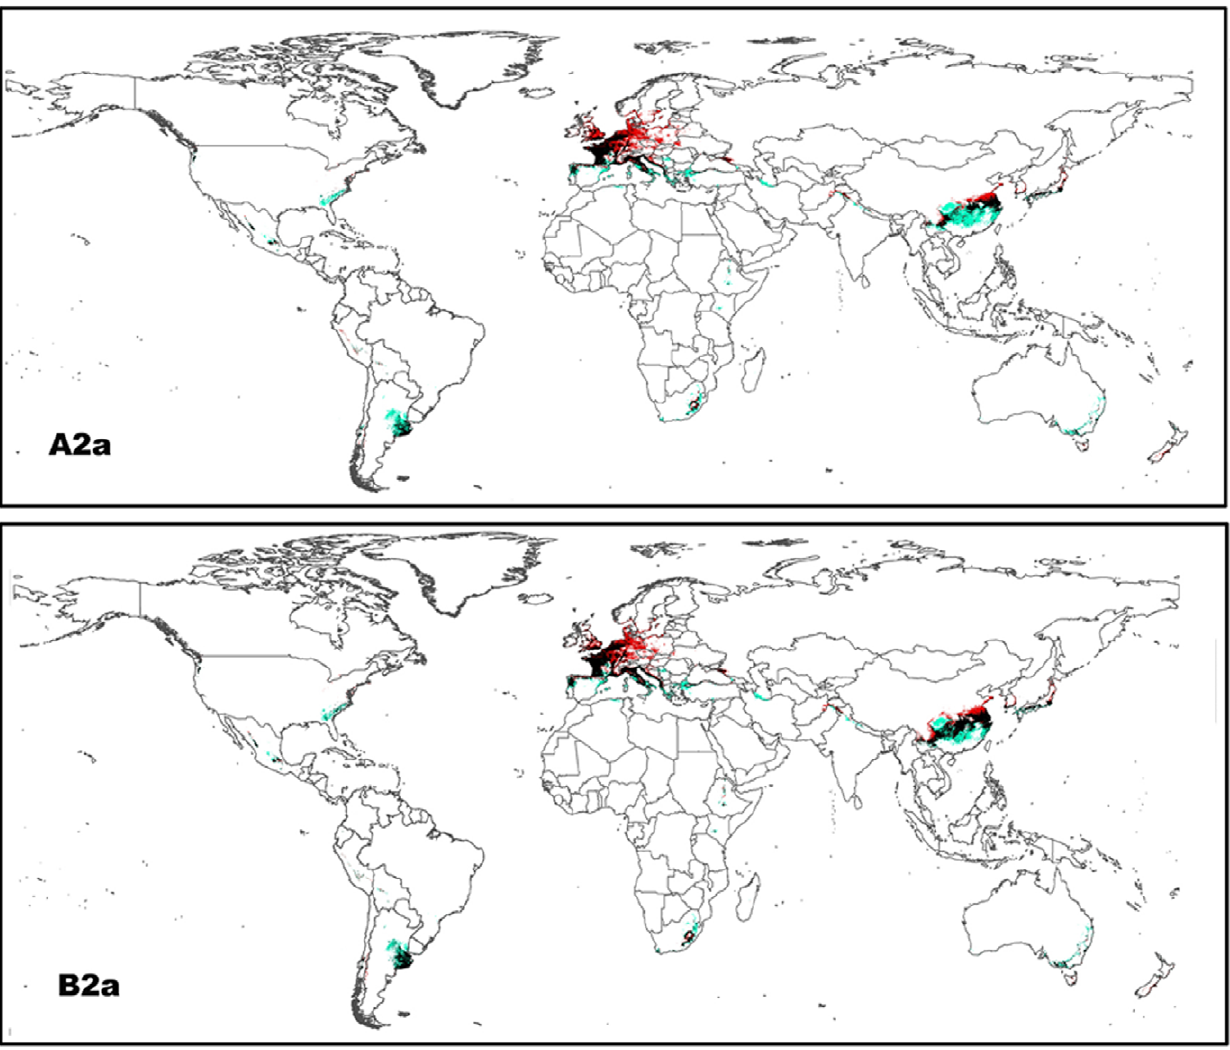
Figure 2. Projected impacts of climate change on future invasive potential of P.clarkii. Models were developed with a consensus-forecast approach using the CCCMA and HADCM3 climate models under two scenarios (A2a and B2a) by 2050: blue = current suitable areas projected to be lost with global climate change; black = current suitable areas projected to be retained; and red = areas projected to become suitable. The predicted suitability is based on the 10th percentile training presence threshold.